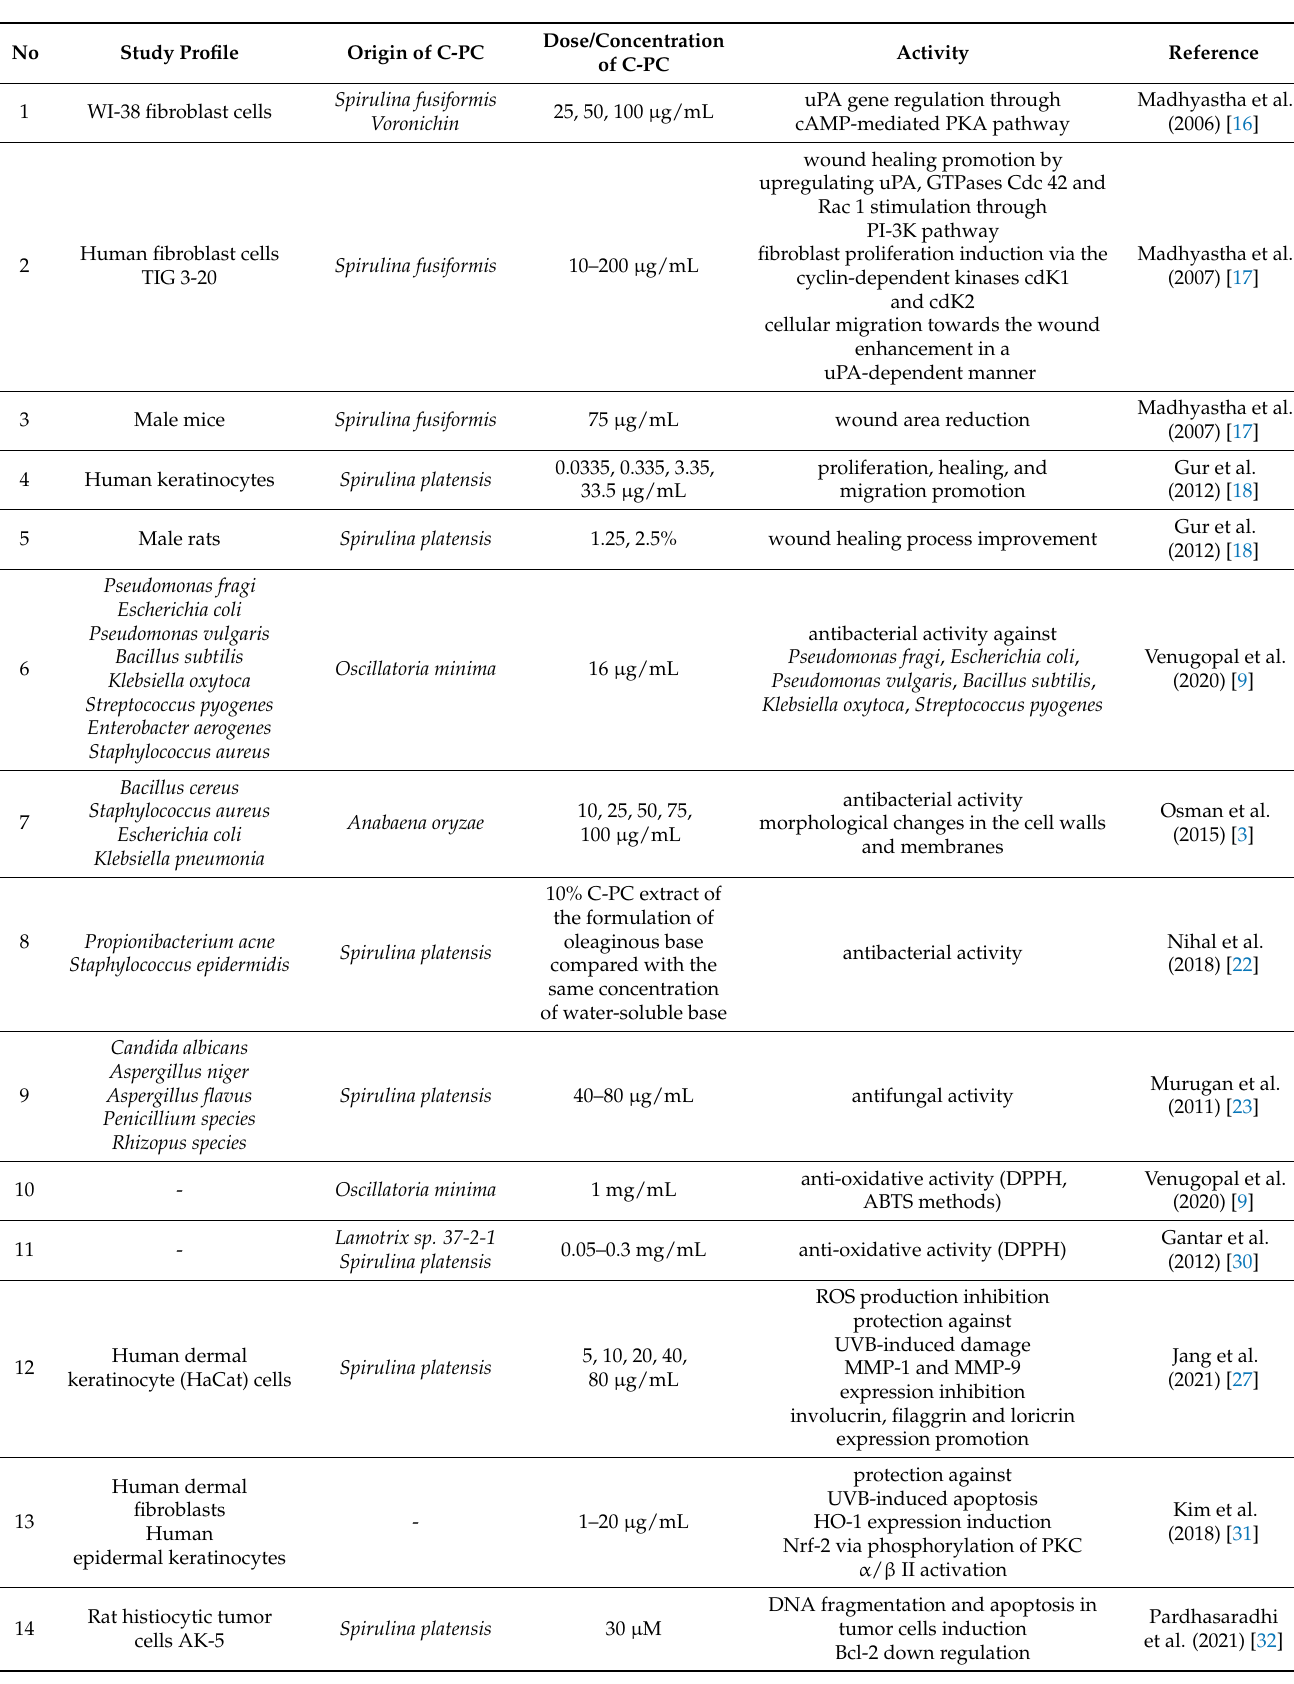
Table 1. Investigations of C-PC topical